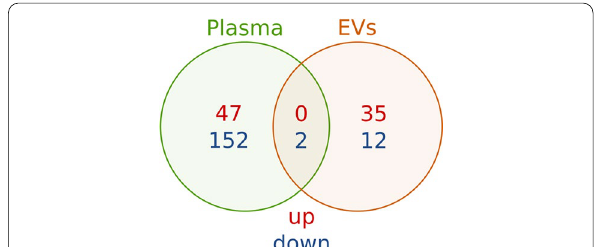
Fig. 1 Venn diagram of differentially expressed miRNAs between ALL survivors and control in plasma, EVs. The red color indicates up‑regulated miRNAs, whereas the blue color indicates the down‑regulated